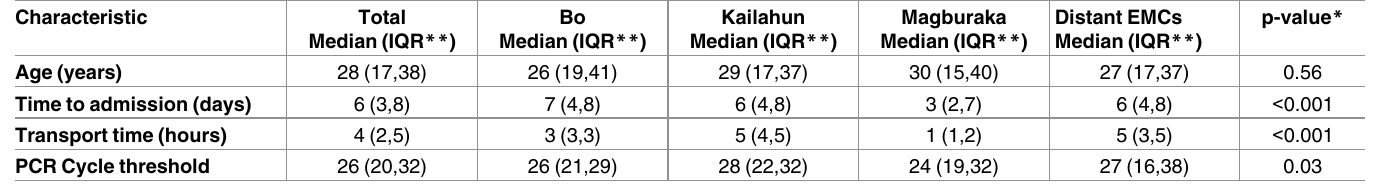
Table 2. Median age, time to admission and transport time of Ebola Virus Disease(EVD) casesfrom Tonkolili, Sierra Leone, by MSF Ebola Manage- ment Centres (EMCs).